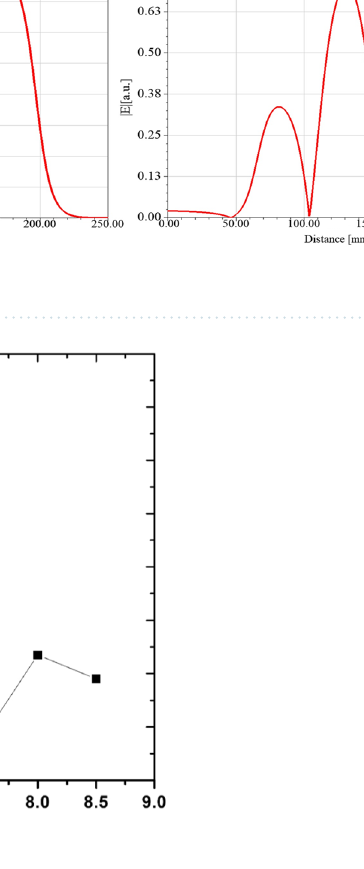
Figure 4. S c values for different thicknesses of the disk for 1 J stored